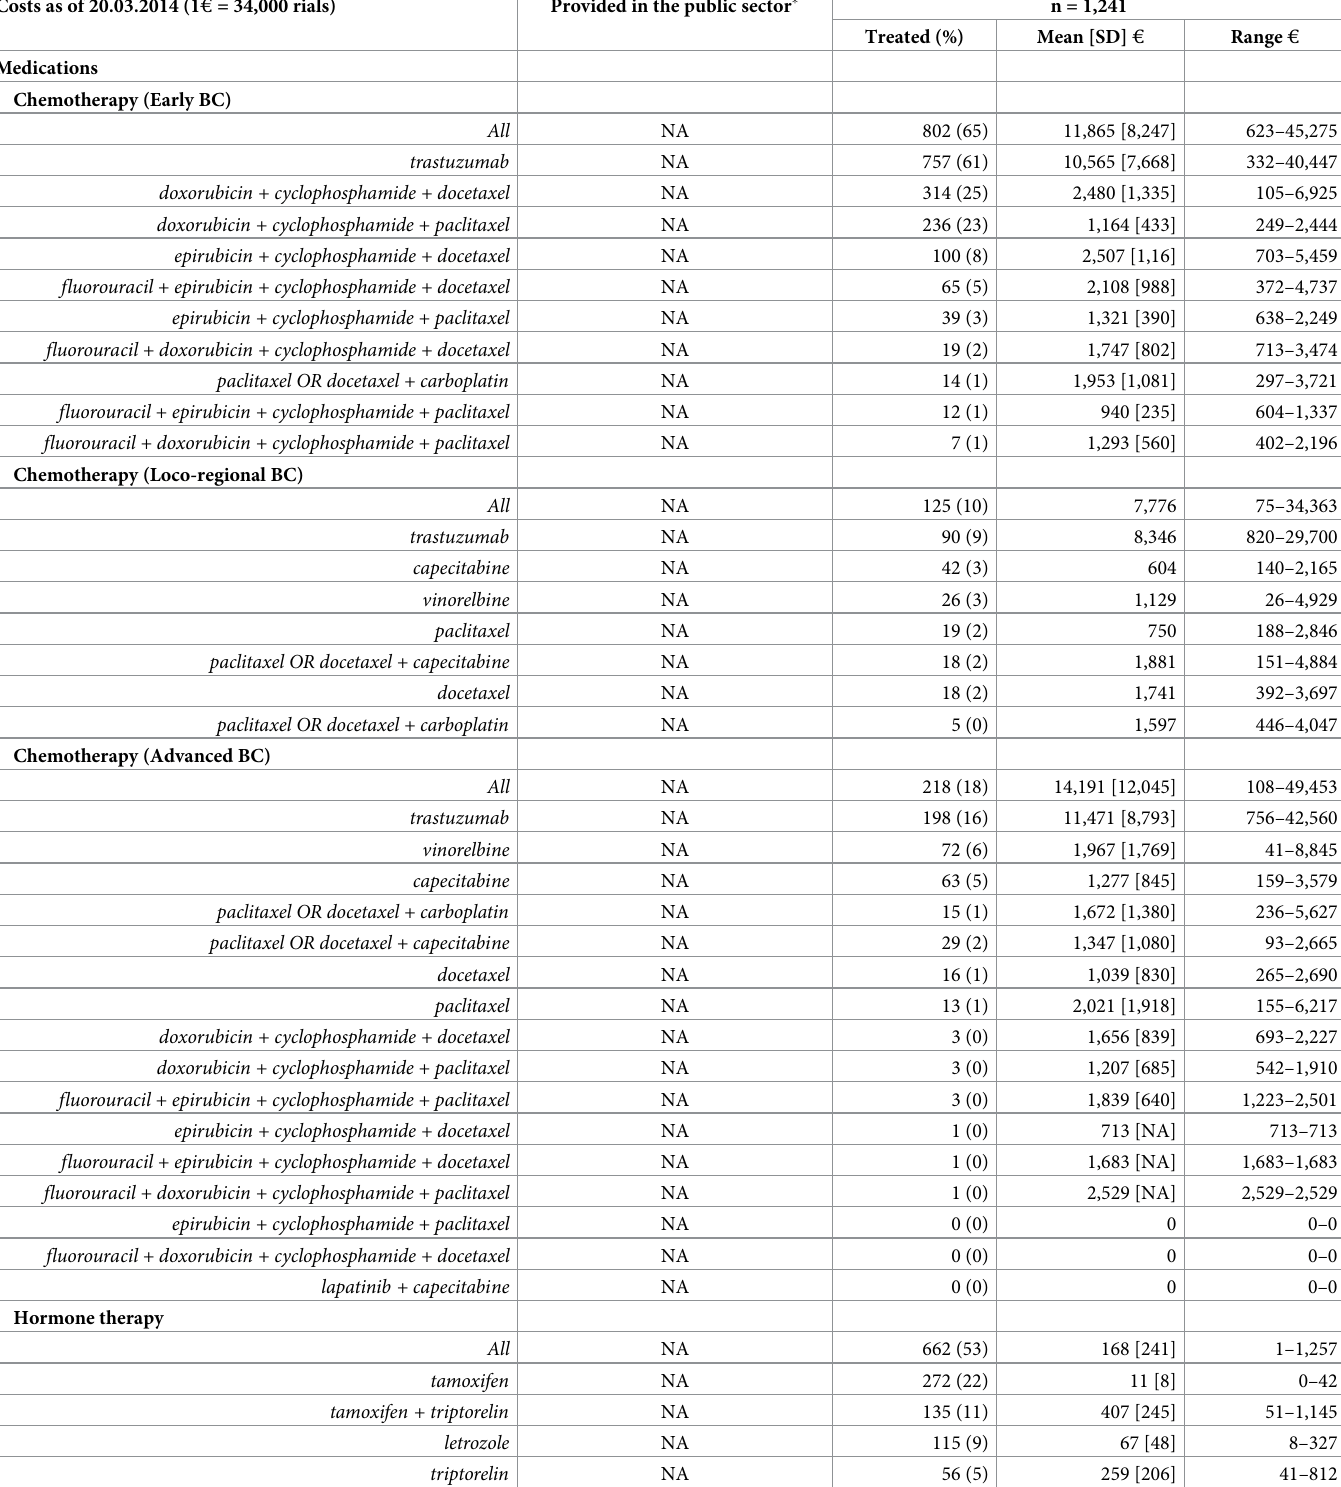
Table 2. Average costs of outpatient services. Costs as of 20.03.2014 (1 € = 34,000 rials) Provided in the public sector